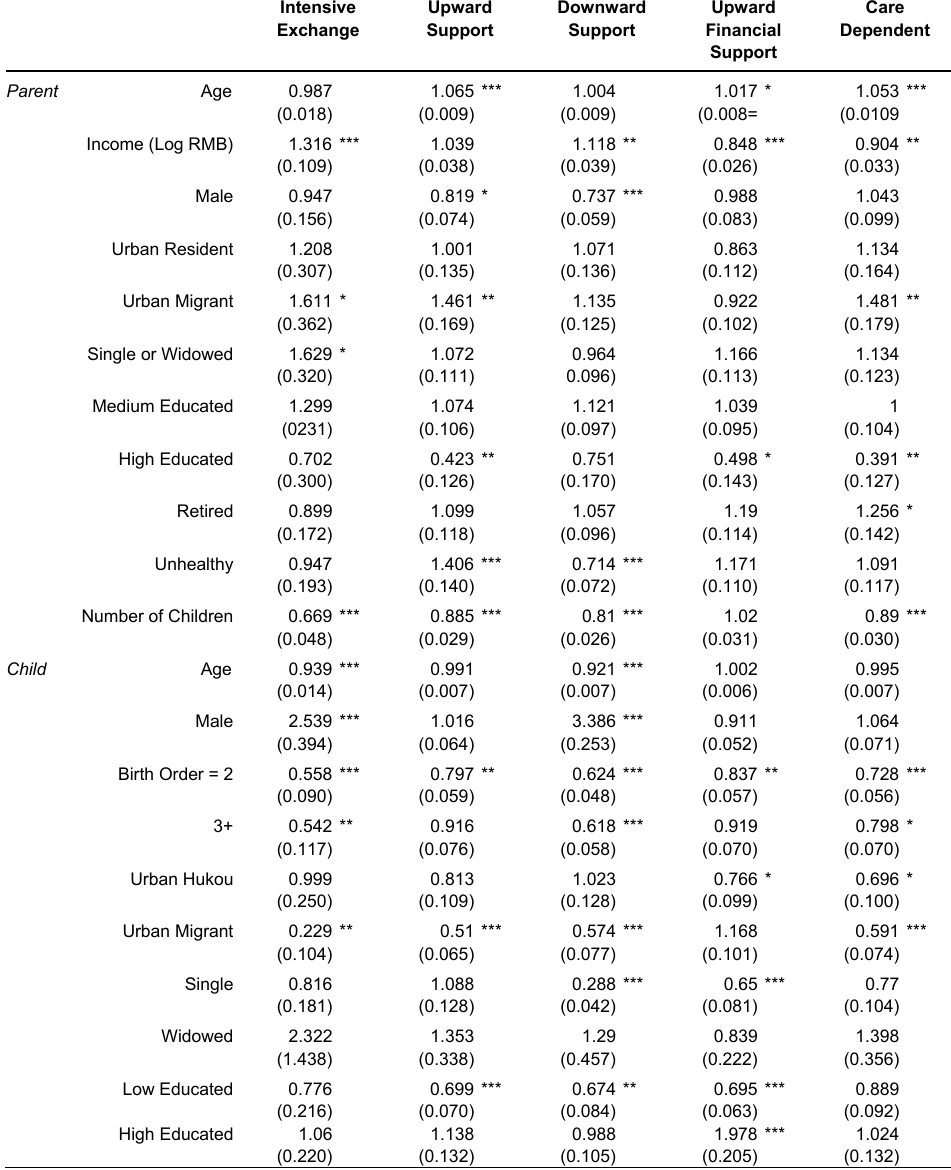
Multilevel Multinomial Model of Parent-Child Relationships (Odds Ratios)